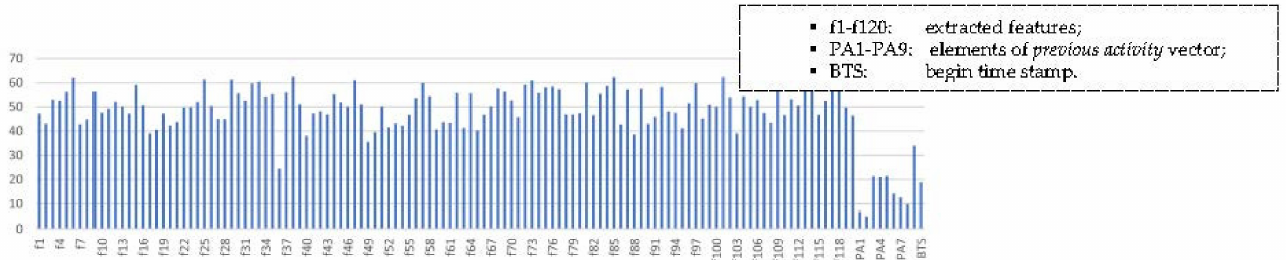
Figure 2. Stacked column graph of absolute values from correlation matrix of